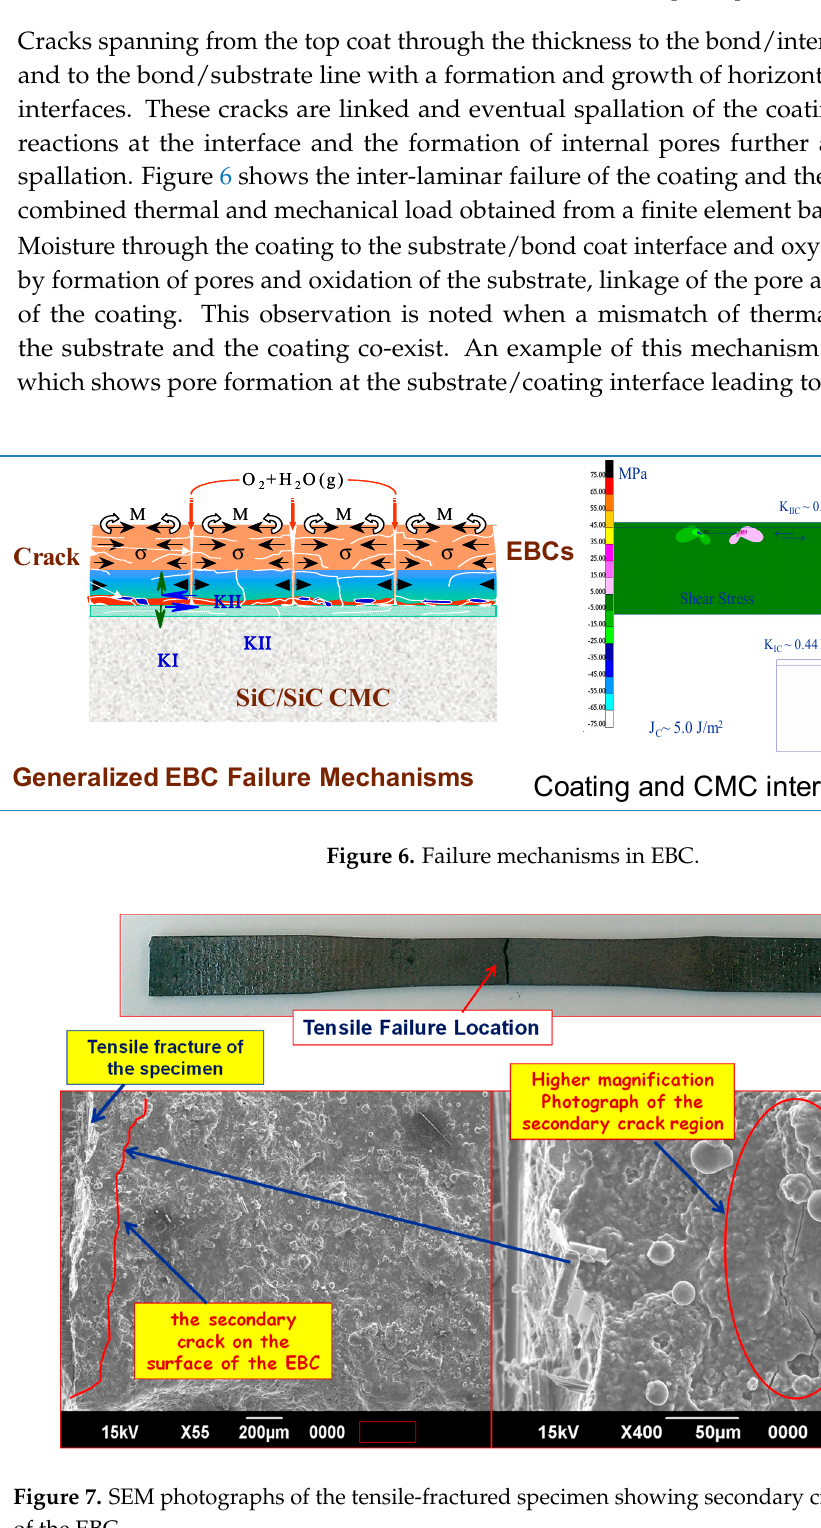
Figure 7. SEM photographs of the tensile-fractured specimen showing secondary cracks on the surface of the EBC.